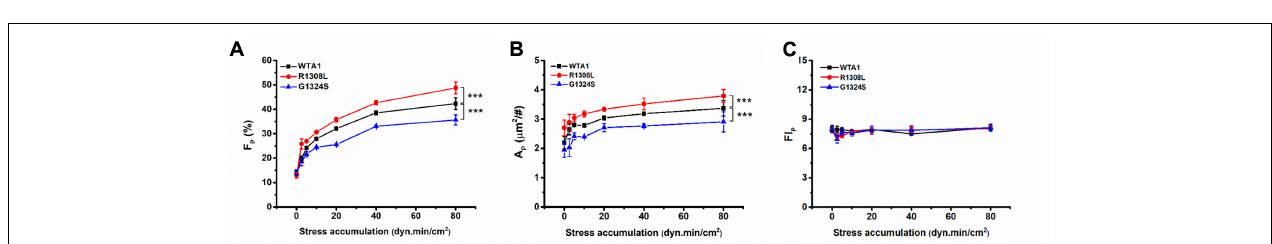
FIGURE 5 | Regulation of shear stress accumulation on von Willebrand factor (VWF)-induced P-selectin translocation. The platelets firmly adhered to substrates coated with WTA1, R1308L, and G1324S, respectively. (A) The mean P-selectin-positive platelet fraction F P , (B) the mean of P-selectin coverage area A P , and (C) the normalized P-selectin-related fluorescence intensity FI P ; all were well correlated with shear stress accumulation, whether VWF-A1 was mutated or not. All data are shown as mean ± SEM from at least three independent experiments and analyzed by two-way ANOVA for multiple comparisons; *** p < 0.001 compared with the WTA1